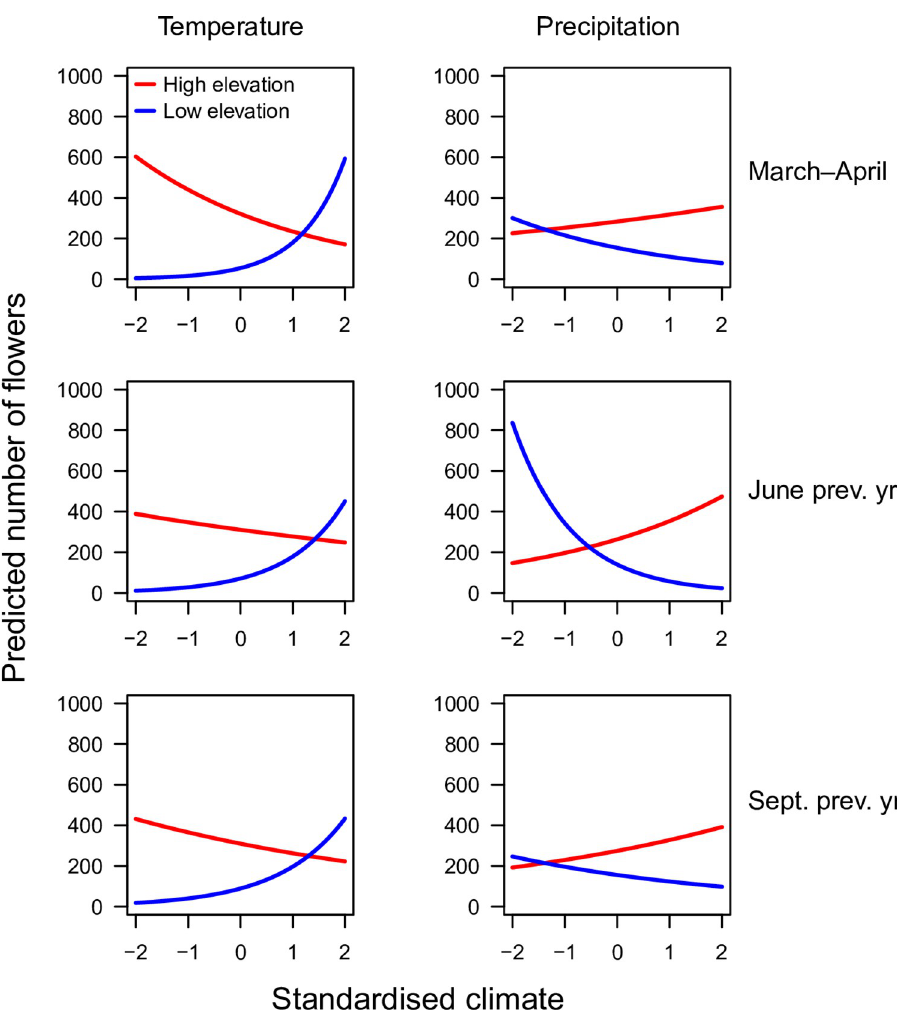
Fig 10. Number of flowering Fritillaria meleagris in response to elevation and temperature or precipitation in the three active periods of the life cycle as predicted by generalised linear mixed models. Red lines show predicted responses at the highest, and blue lines at the lowest elevation. Statistical analyses are summarised in S8 Appendix.